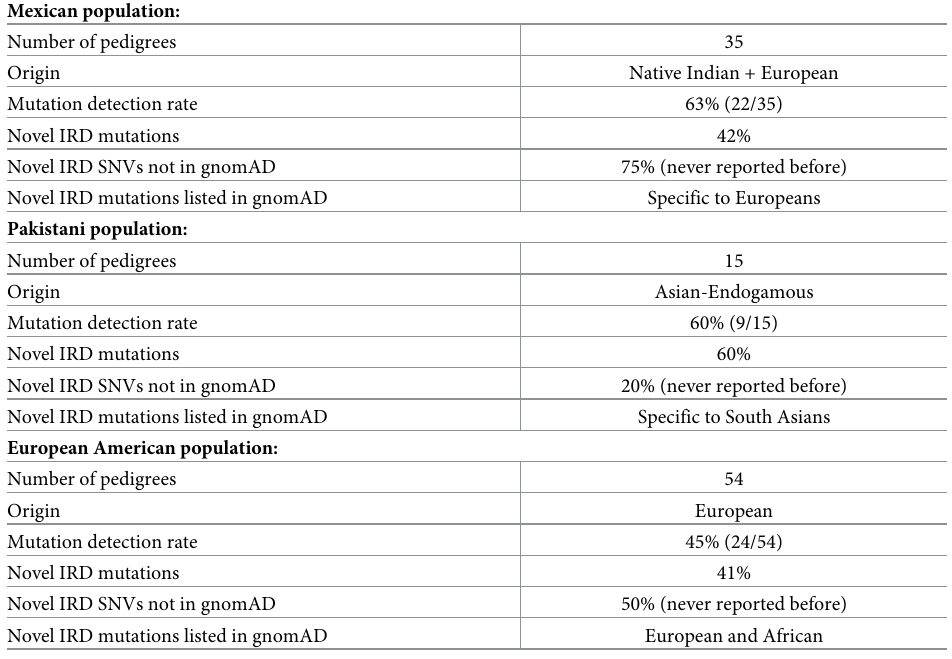
Table 5. Summary of findings and population distribution of mutations detected in three major cohorts analyzed. Mexican population: Number of